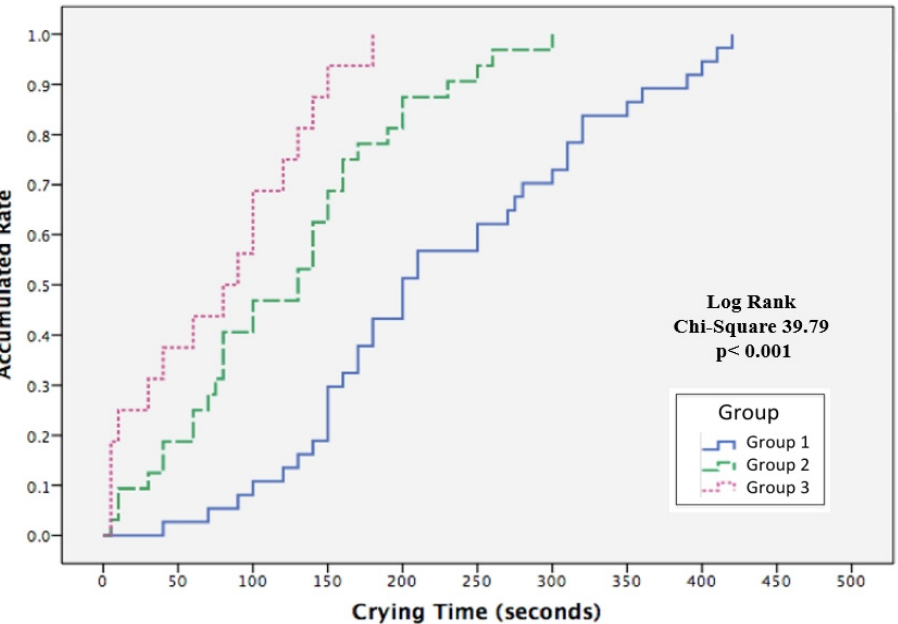
Figure 5. Kaplan–Meier survival analysis comparing the accumulated rate of time to cessation of crying during heel-prick procedures for neonates in the three treatment groups. Groups: 1 (blue), gentle touch plus human voice (control condition); 2 (green), control condition + breast milk odor; 3 (pink), control condition + breast milk odor + breast milk taste by syringe feeding. Table 4. Comparison of group effects on crying cessation during heel prick for neonates using Cox regression after adjusting for gestational age.